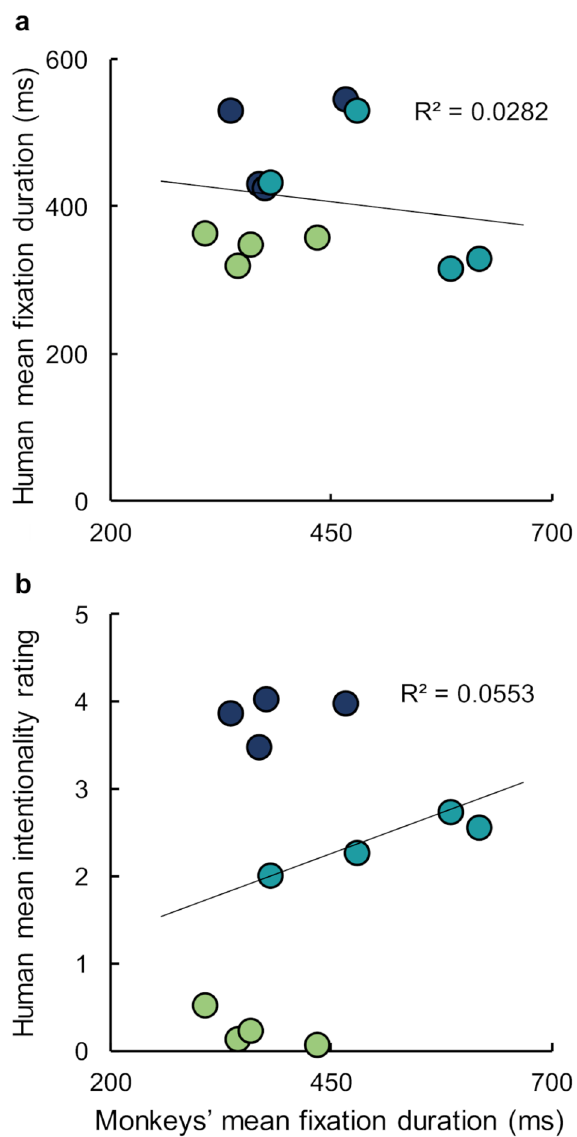
Figure 4. Monkeys’ mean fixation duration did not significantly correlate with humans’ fixation durations or intentionality ratings (data from Klein et al. 8 ). ( a ) Monkeys’ mean fixation duration (ms) for each animation as a function of the humans’ mean fixation duration reported in Klein et al. 8 . ( b ) Monkeys’ mean fixation duration (ms) for each video as a function of humans’ intentionality ratings (0–5; 0 = nondeliberate action and 5 = deliberate action with the goal of affecting the other’s mental state). Each symbol represents data from a single animation. Colors represent animation categories, and match assignments used in Figs. 1, 2 and